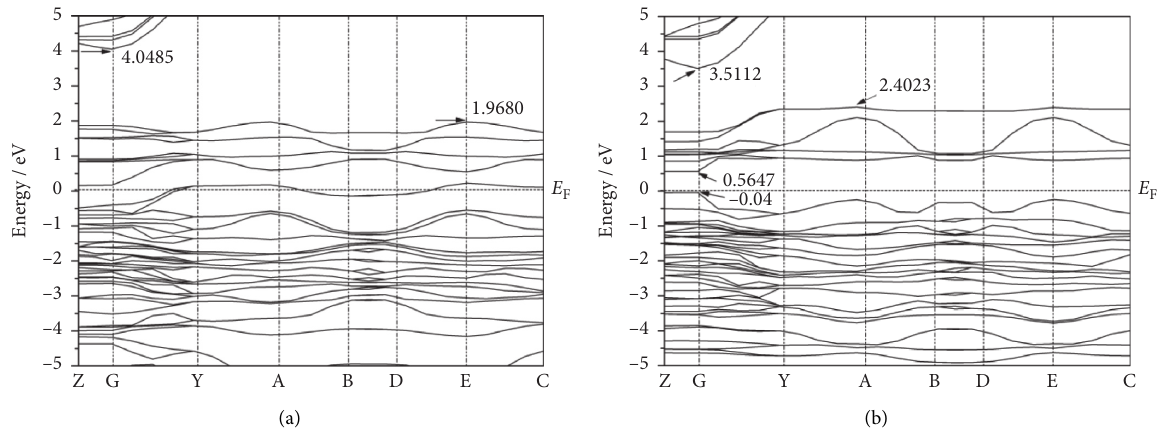
Figure 6: Detailed electron band structures of sandwiched Ca